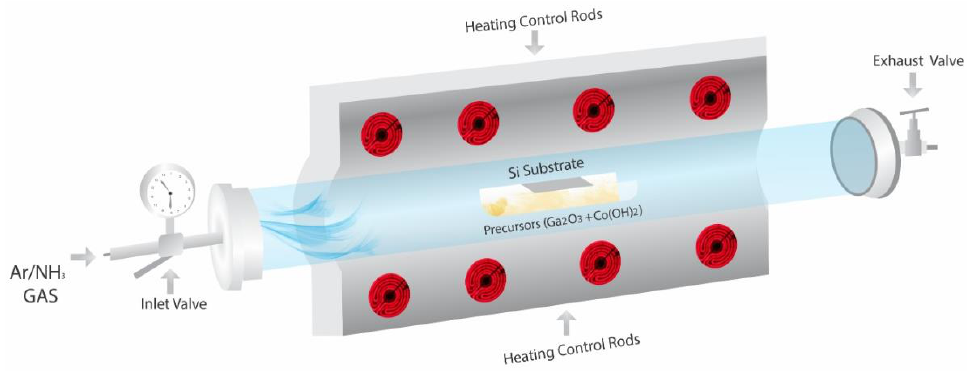
Figure 1. Schematic diagram of chemical vapor deposition (CVD) process.